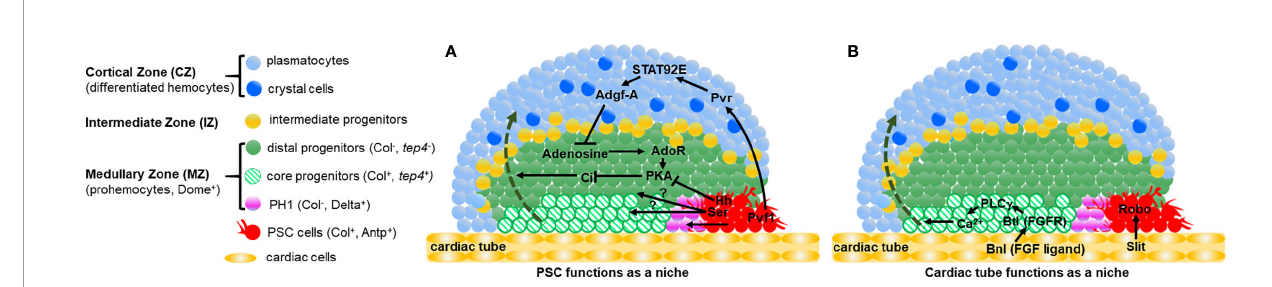
FIGURE 2 | Two niches control lymph gland homeostasis. (A, B) Schematic representation of third instar larva lymph gland anterior lobes. The medullary zone (MZ) contains three types of progenitors: distal progenitors and core progenitors are in green and hatched green, respectively, and the PH1 is in pink. Intermediate progenitors are in yellow, plasmatocytes and crystal cells in the cortical zone (CZ) are in light and dark blue, respectively. The PSC and the cardiac tube/vascular system are in red and orange, respectively. (A) Differentiated hemocytes result from progenitors ’ differentiation (green dashed arrow) In a wildtype (WT) lymph gland, under homeostatic conditions, the PSC regulates the maintenance of a subset of MZ progenitors. Hedgehog (Hh) is required for maintaining distal progenitors. PSC signals required for controlling PH1 remain to be identi fi ed, as well as the progenitor subset controlled by Ser expressed in the PSC. Pvf1 secreted by the PSC, controls progenitor maintenance via differentiated hemocytes. (B) The cardiac tube corresponds to a second niche present in the lymph gland. The FGF ligand Branchless (Bnl) activates its receptor Breathless (Btl) in progenitors. Btl-FGF activation regulates intracellular Ca 2+ levels via PLC g , and controls the maintenance of core progenitors and in turn the whole progenitor pool. The ligand Slit produced by cardiac cells activates its Robo receptors in the PSC. Robo signaling controls PSC cell clustering and